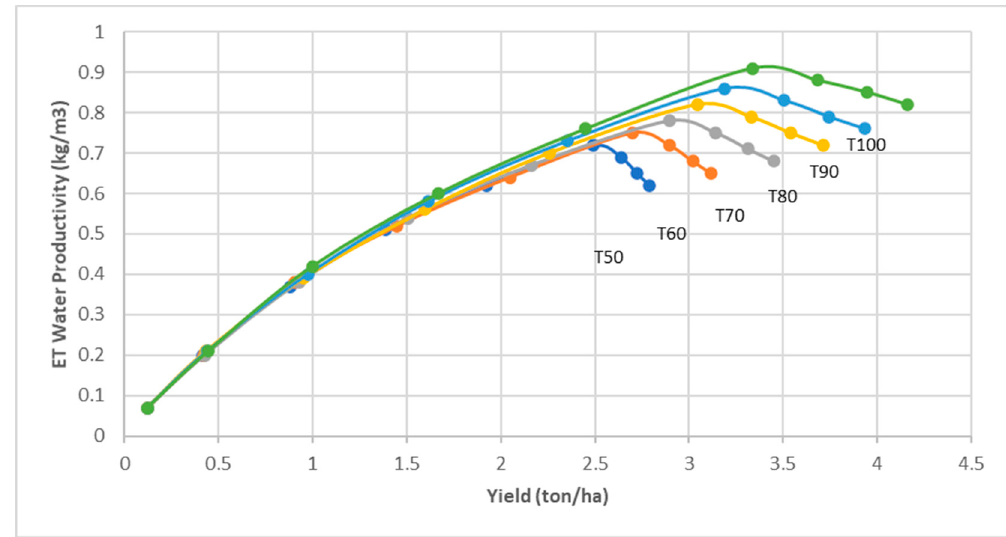
Figure 6. The productivity coefficient versus crop yield for the winter wheat crop.